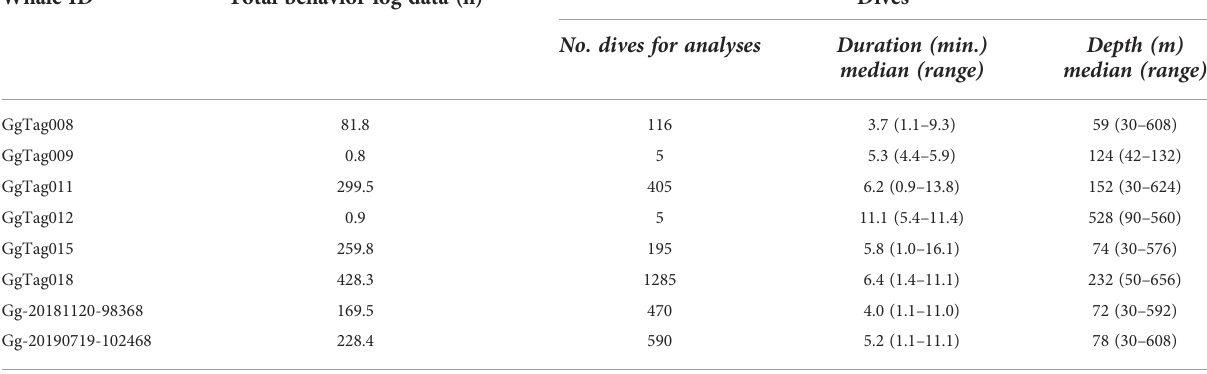
TABLE 4 Summary of dive parameters by individual of eight Risso ’ s dolphins satellite-tagged within the Southern California Bight. Whale